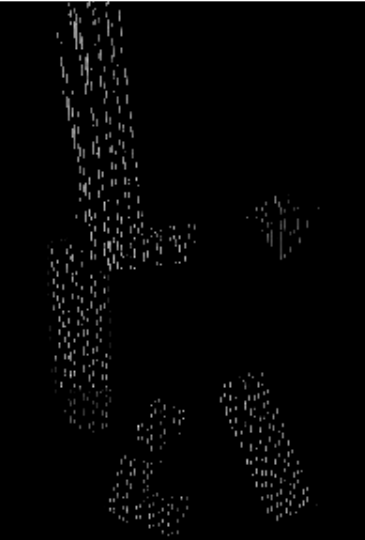
Figure 2. This is the result from extracting buildings inside the study area. As the figure shows each building has a specific shape.